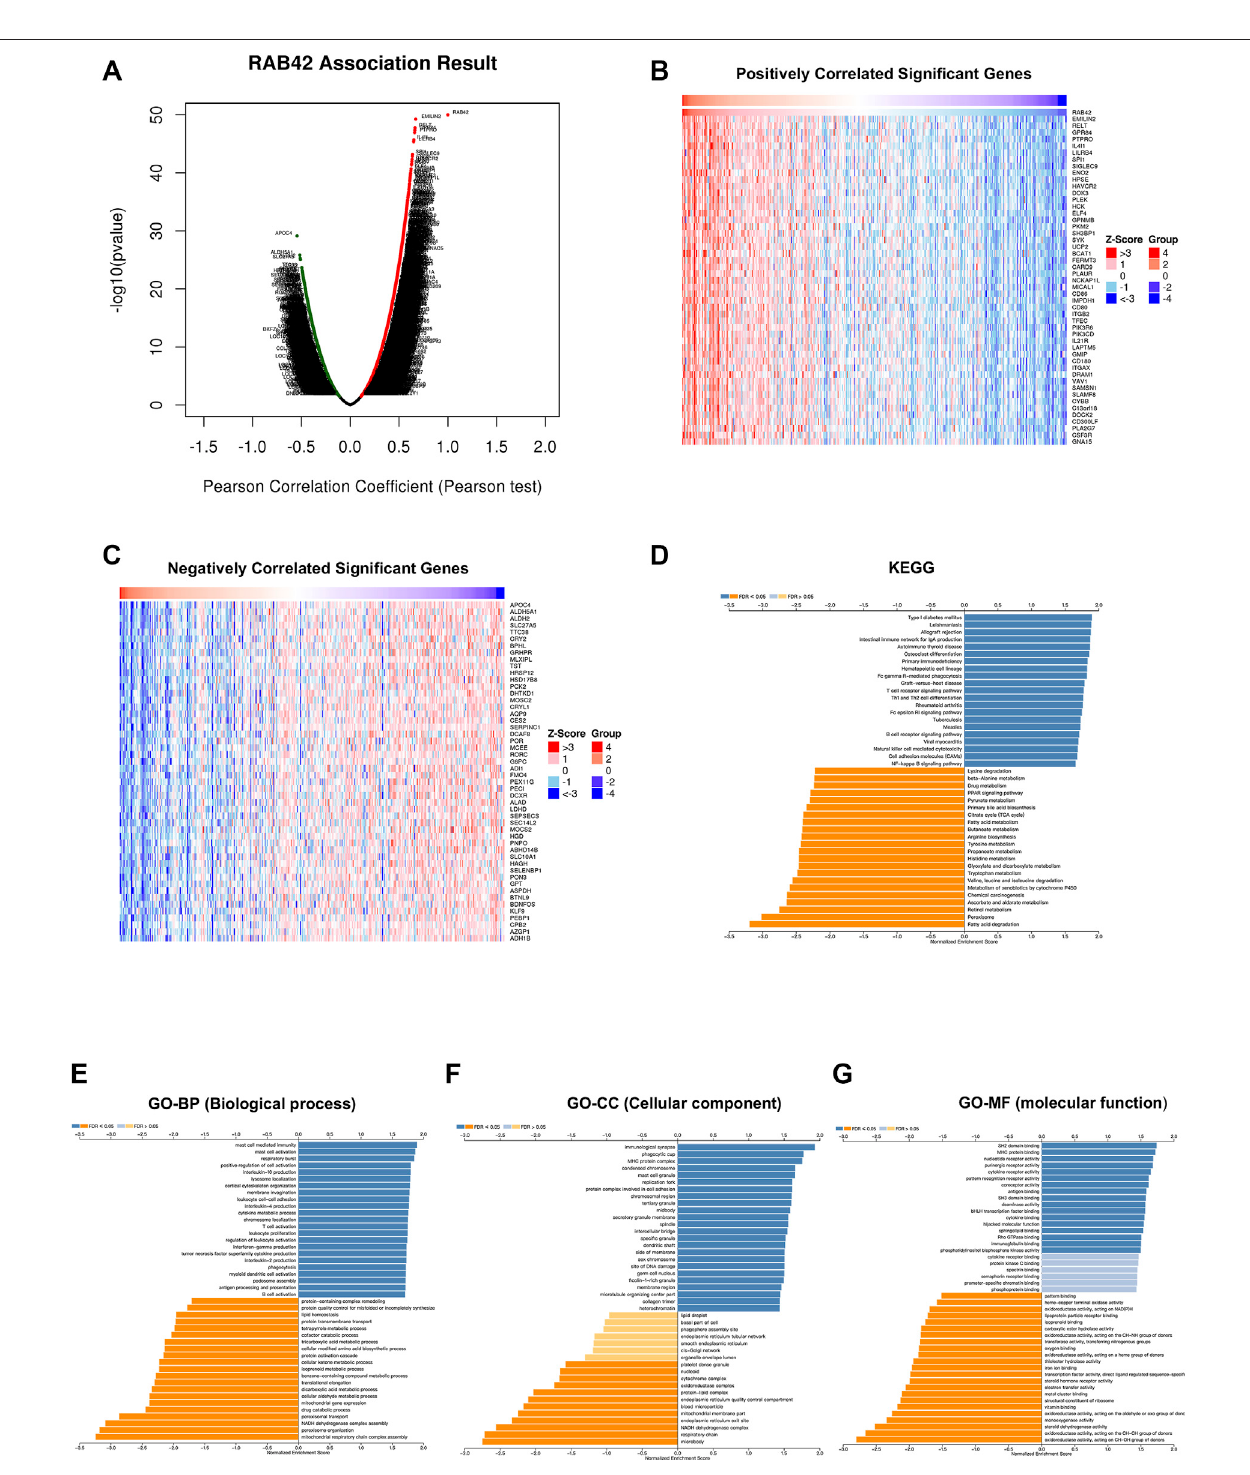
FIGURE 6 | RAB42 co-expressed genes and KEGG, GO enrichment analysis in HCC patients. (A) Volcano plots showed the differentially co-expressed genes of RAB42inHCCbytheLinkedOmicsdatabase. (B , C) Theheatmapshowedthetop50positively (B) andnegatively (C) differentiallycorrelatedgenesofRAB42inHCCby the LinkedOmics database. (D) KEGG enrichment analysis revealed diseases and signaling pathways related to RAB42 co-related genes. (E – G) RAB42 co-expressed genes were annotated by using GO analysis. KEGG, Kyoto Encyclopedia of Genes and Genomes; GO, Gene Ontology; BP, Biological Process; CC, Cellular Component; MF, Molecular